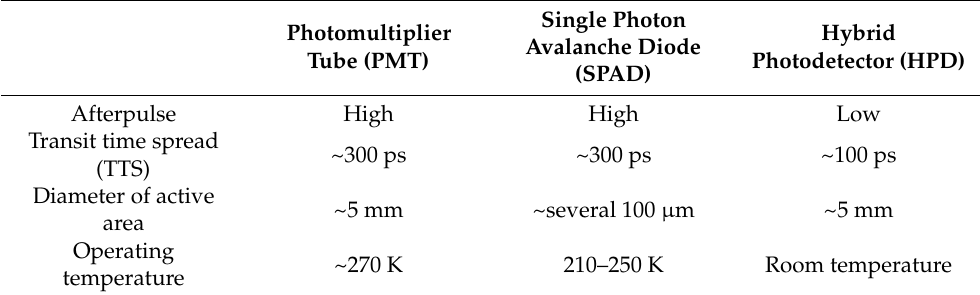
Table 2. Characteristics of point photodetectors [23,27,32].